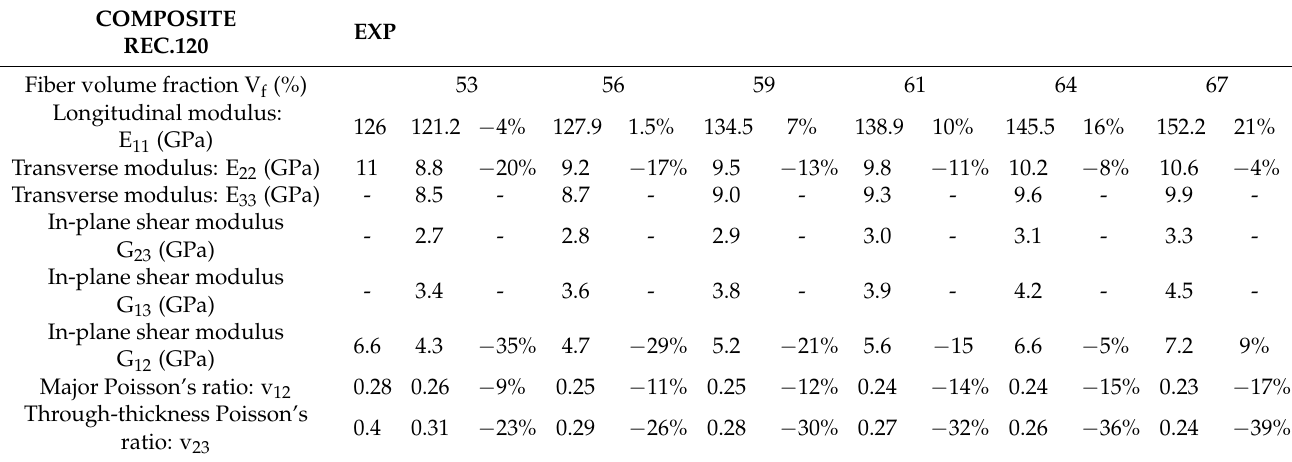
Table 9. Comparisons between the measured experimental (EXP) and the predicted effective properties for PERIODIC PACKAGING ARRANGEMENT REC.120 with different fiber volume fraction